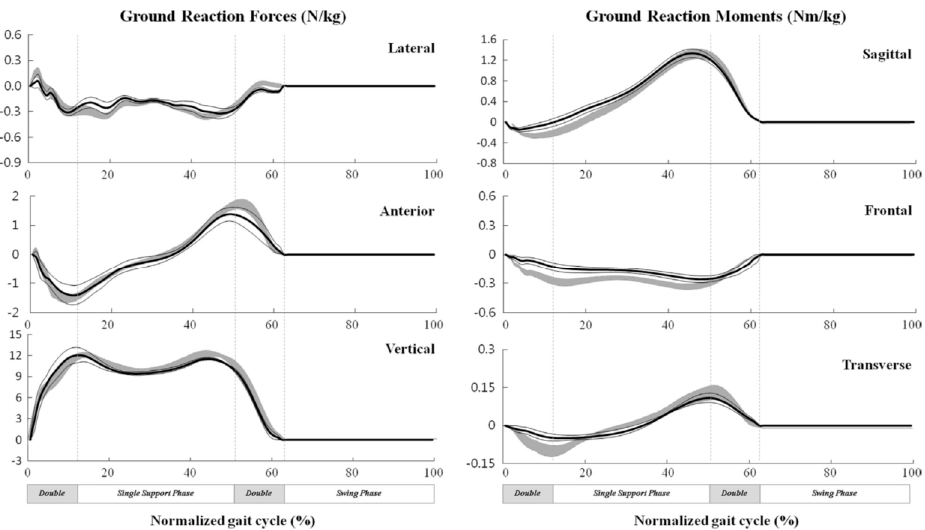
Figure 7. Estimated GRF&Ms normalized by body mass (mean (thick line) ± 1 SD (thin lines), compared with forceplate data (mean ± 1 SD (shaded area)) (after [26]).